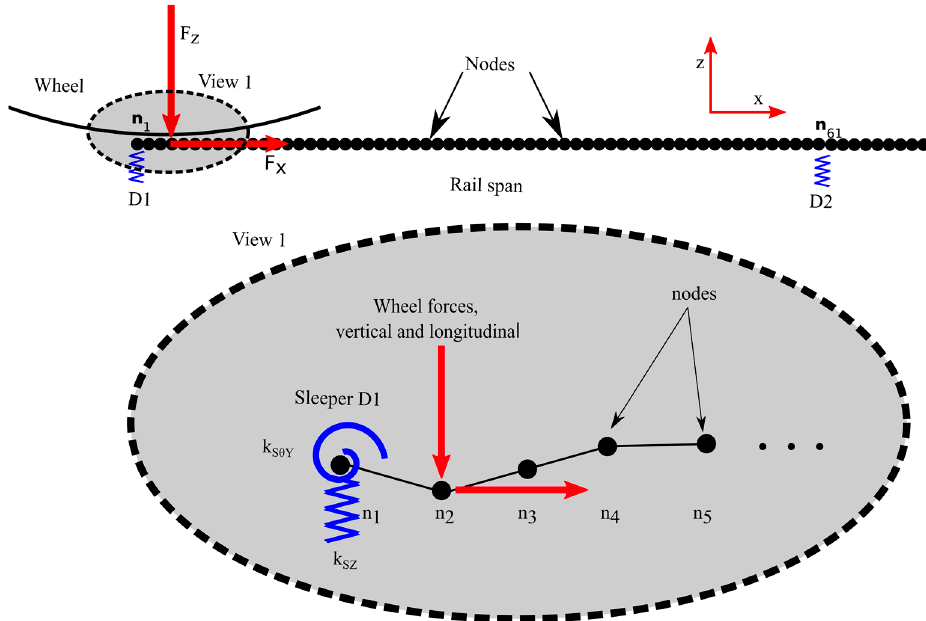
Figure 3. The FEM model of the rail. The wheel forces are applied to one-by-one nodes at each step of the simulation. View 1 illustrates in detail how the interaction forces are applied to the nodes.